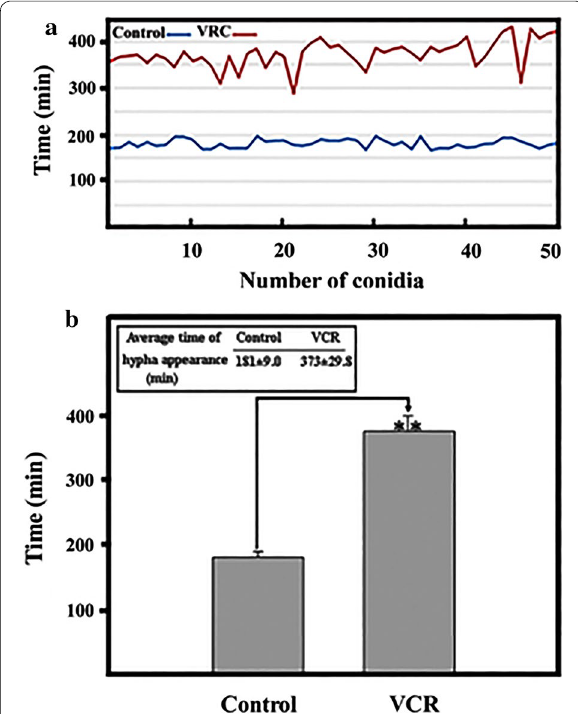
Fig. 3 Time of hypha outgrowth. a Germination times of 50 selected conidia of A. fumigatus . b Average time of the appearance of hyphae. Upon treatment with AMB, conidia did not germinate. Treatment of conidia with VRC did not stop but significantly delayed early appearance of hyphae is an important virulence indicator of pathogenic fungi whereas delayed hyphae outgrowth is an indication of antifungal effect. SD. ±